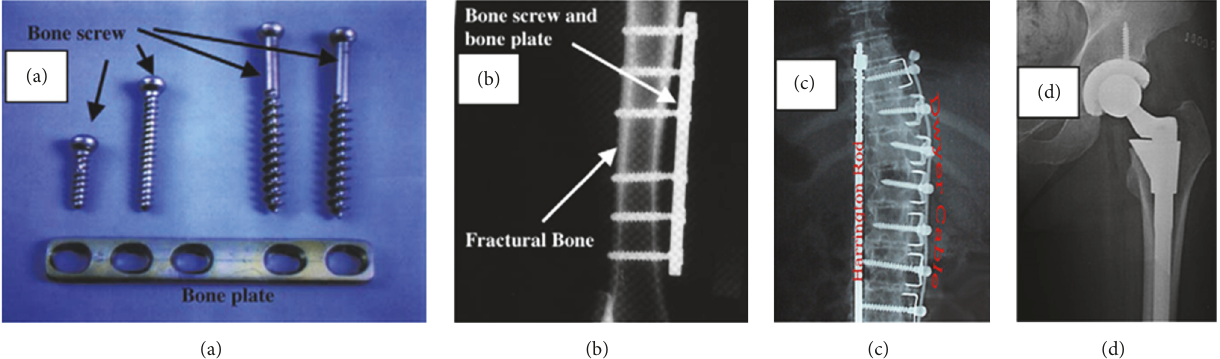
Figure 1: (a) Bone plate screws. (b) Implanted bone plate and screws. (c) The Harrington rod. (d) The stem of the total hip replacement (SS, Co-based, or Ti-based alloys) [41,